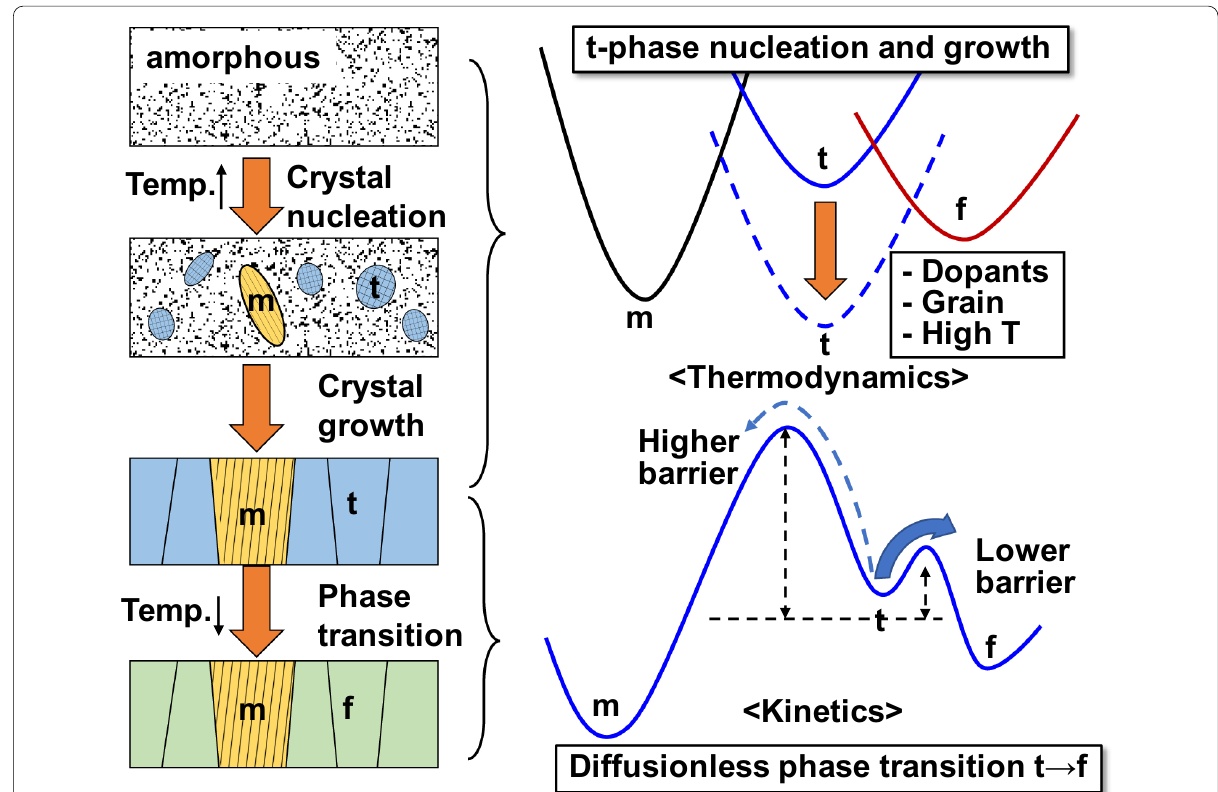
Fig. 3 Schematic illustration of the mechanism of the f-phase formation from amorphous HfO 2 in thermal